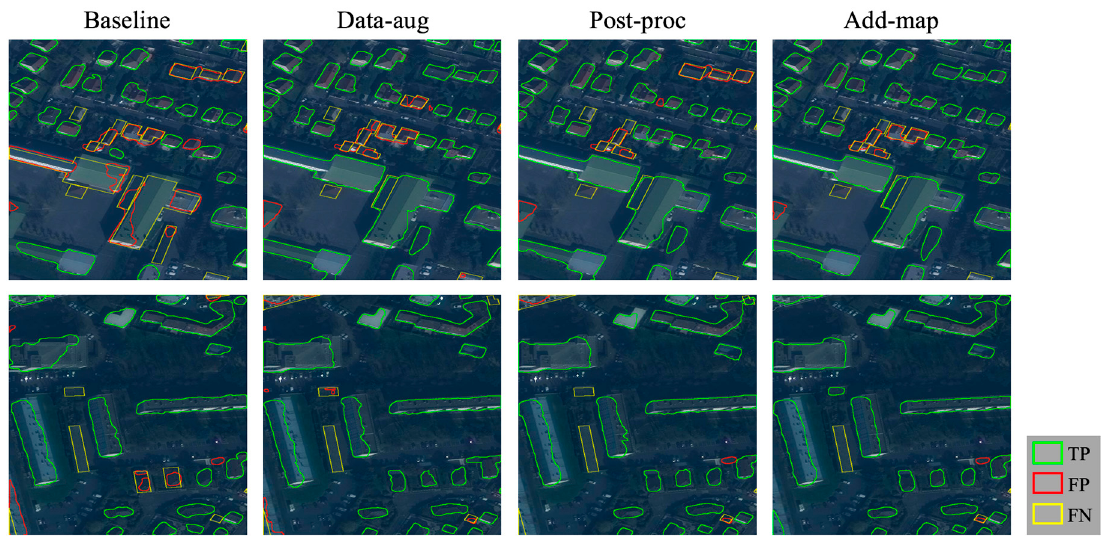
Figure 7. Examples of building extraction results for Paris using different strategies.